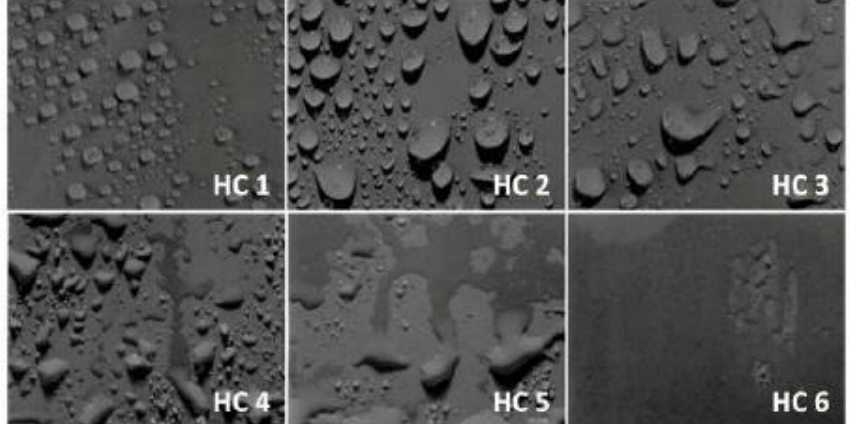
Figure 4. STRI hydrophobicity guide.